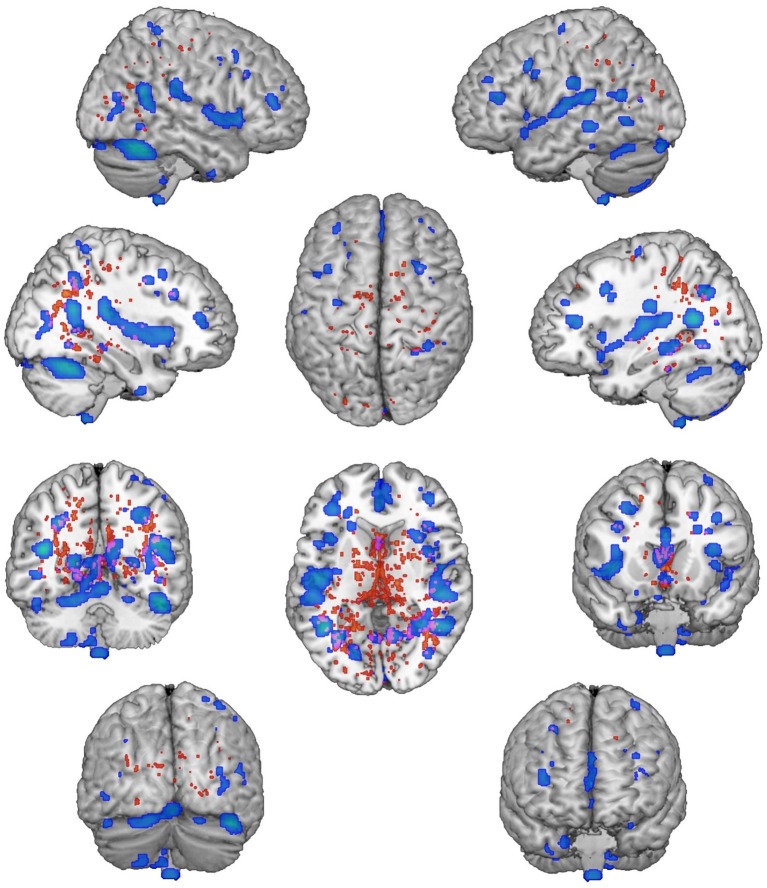
IC11 Pattern. The figure depicts the covariance pattern of IC11 highlighted by joint ICA. Statistical maps are thresholded at z = 2.5 for visualization purposes. Gray-matter clusters and white-matter clusters including all DTI metrics (i.e., FA, MD, AD, RD) are shown in blue-green and red-yellow colors, respectively.